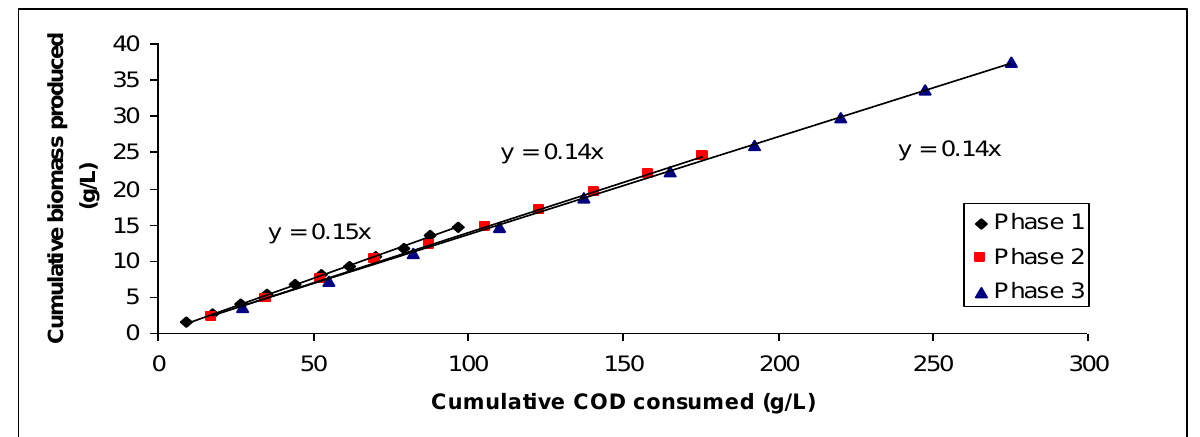
Figure 5. Biomass yield.